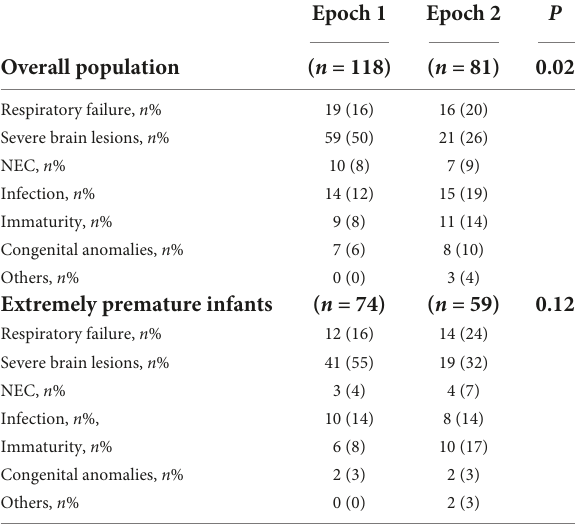
TABLE 4 Causes of death according to the epochs in the overall population, and in extremely premature infants (born < 27 weeks’ gestational